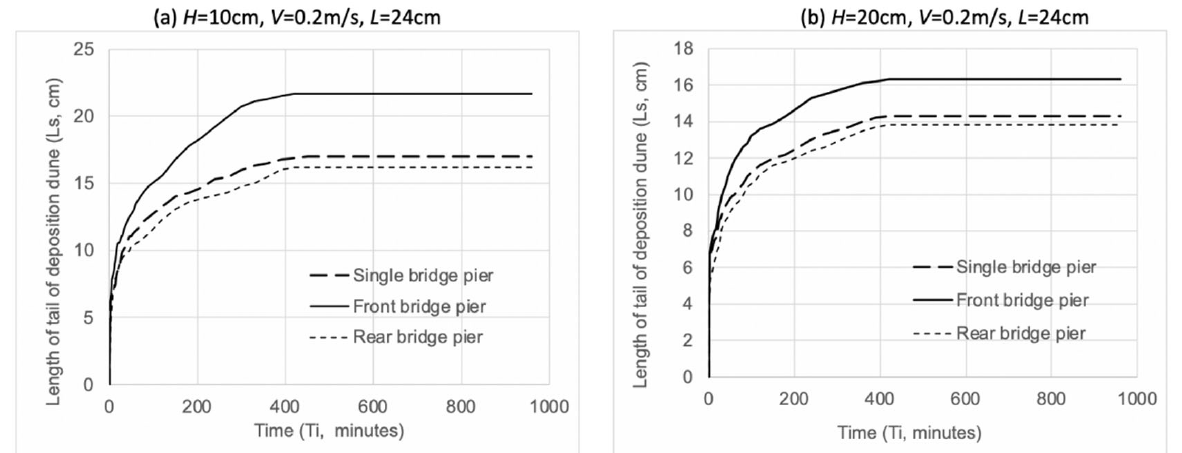
Figure 5. Variation in tail length of deposition dune ( L S ) with time ( T i ). ( a ) H = 10 cm, V = 0.2 m/s, L = 24 cm; ( b ) H = 20 cm, V = 0.2 m/s, L = 24 cm).